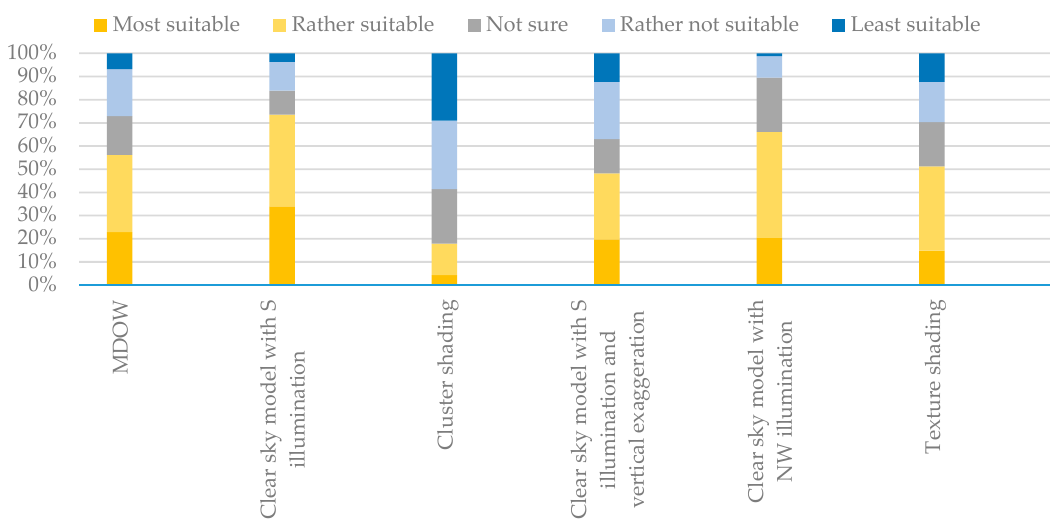
Figure 13. Survey results for U-shaped valleys.